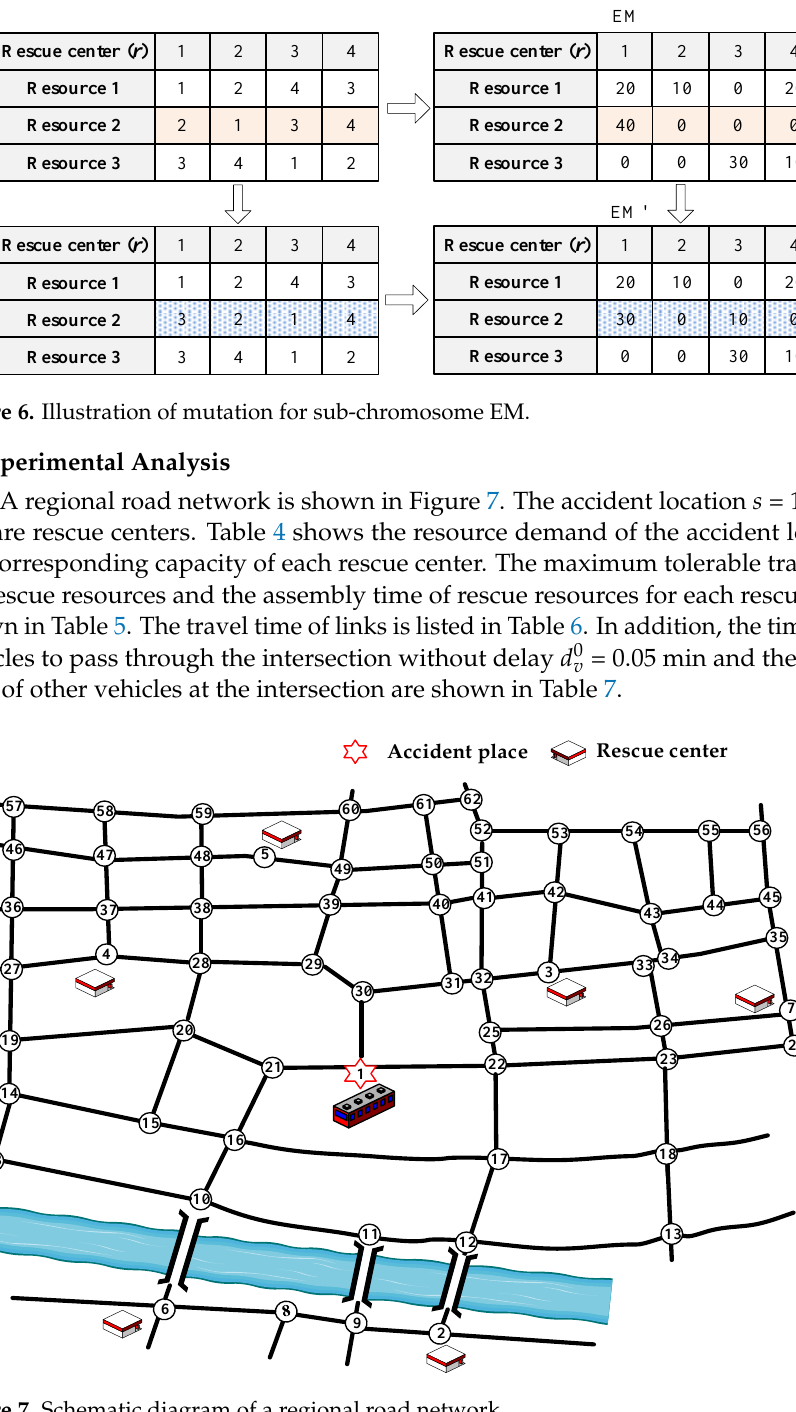
Figure 7. Schematic diagram of a regional road network. Table 4. Demand for rescue resources and rescue capacity of rescue centers. Rescue Resource